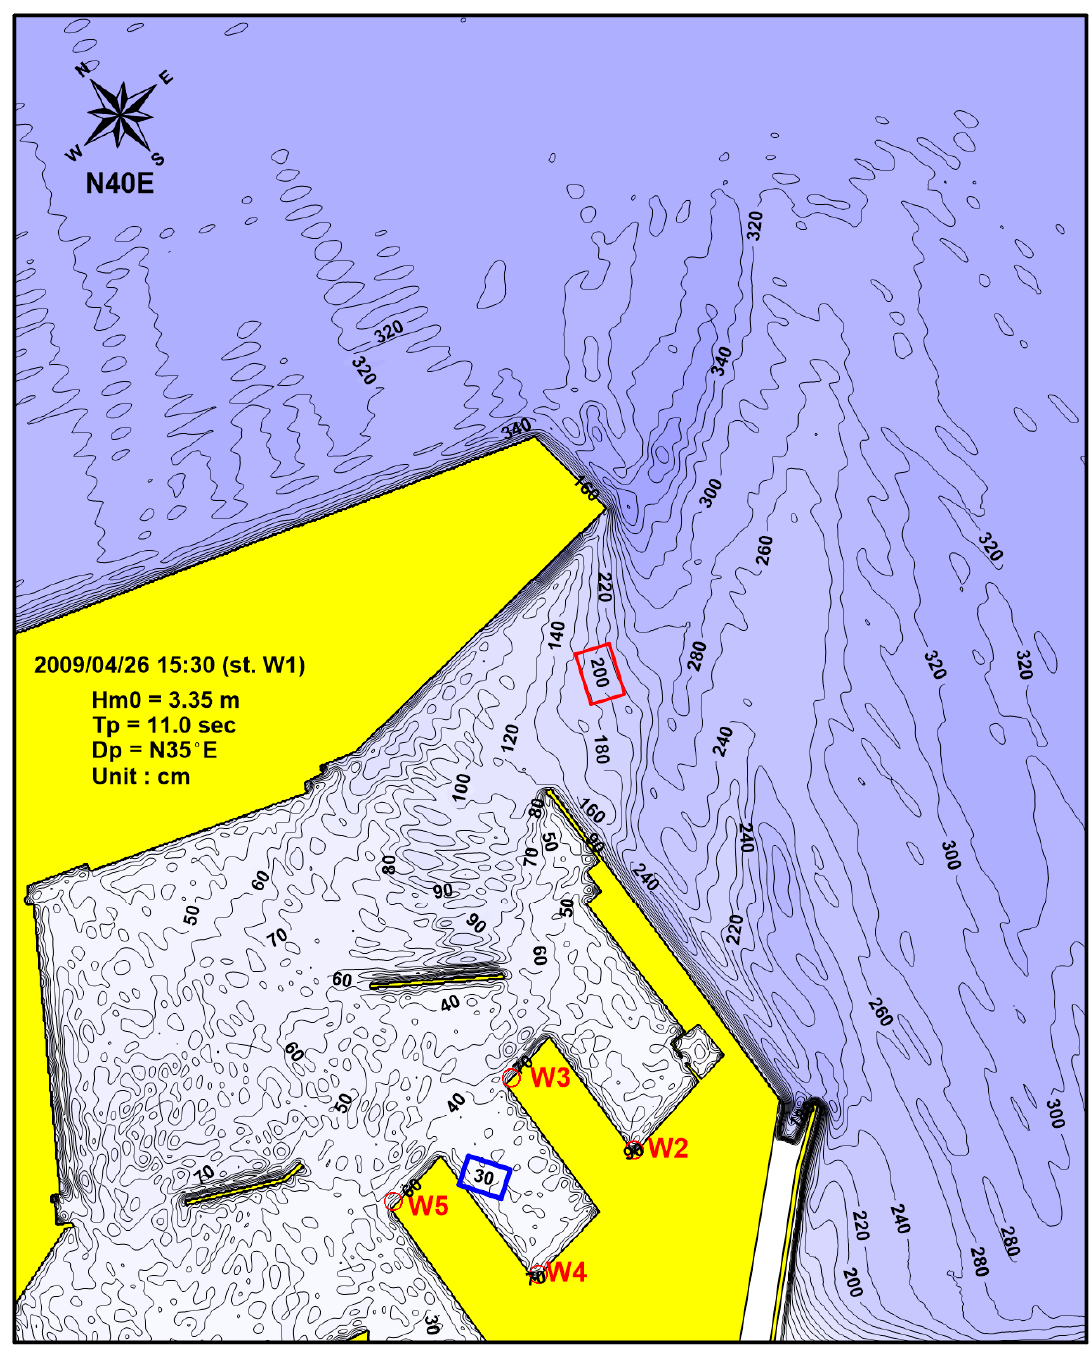
Figure 16. Contours of wave height isolines at 15:30 on 26 April 2009 when the H m 0 value became maximum during the 39 h of the simulation time shown in Figure 12, in the case of BC. The input H m 0 was 3.35 m at the open boundary, which was reduced to 2.0 m (40% reduction) near the entrance of Pohang New Port (marked in a red rectangle) and to 0.3 m inside the slit near W4 and W5 (marked in a blue rectangle).